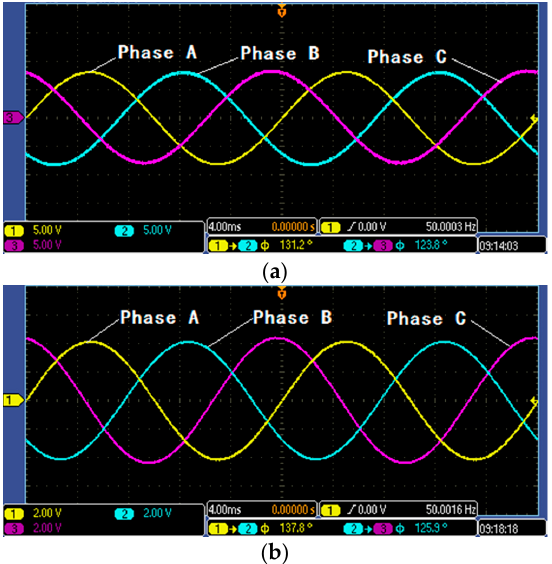
Figure 21. Waveform figure: ( a ) Signal of high-voltage probe under 8 kV; and ( b ) signal of voltage sensor under 8 kV.